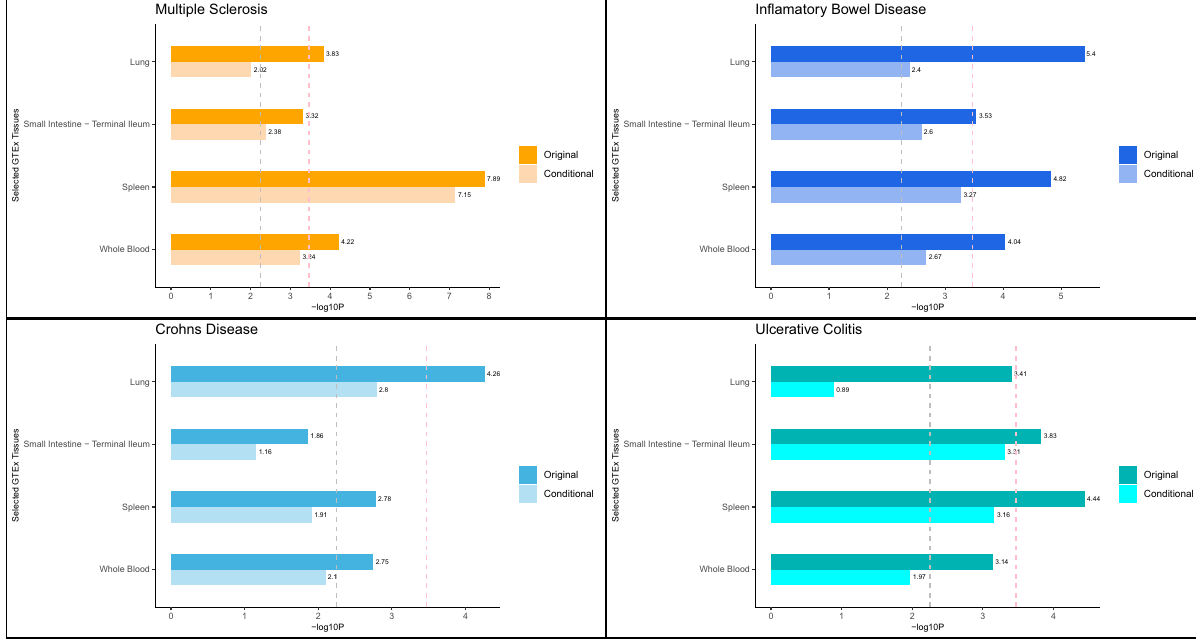
Fig. 4 Tissue type-speci fi c enrichment of single nucleotide polymorphism (SNP) heritability for multiple sclerosis (MS), in fl ammatory bowel disease (IBD), ulcerative colitis (UC) and Crohn ’ s disease (CD) in immune tissues estimated using strati fi ed linkage disequilibrium score regression (S-LDSC). Negative log10 p -values of coef fi cient Z -scores for each individual test (two-tailed Z -test) are displayed on the x axis. The grey and pink dotted lines represent the FDR threshold <5% and Bonferroni corrected threshold for multiple comparisons, respectively. Original indicates results from S-LDSC analyses adjusted for the baseline model and the set of all genes. Conditional indicates results from conditional S-LDSC analyses that additionally adjusted for the set of genes speci fi cally expressed in the three non-focal tissues (e.g. small intestine – terminal ileum, lung and whole blood in analyses of spleen). Source data are provided with this